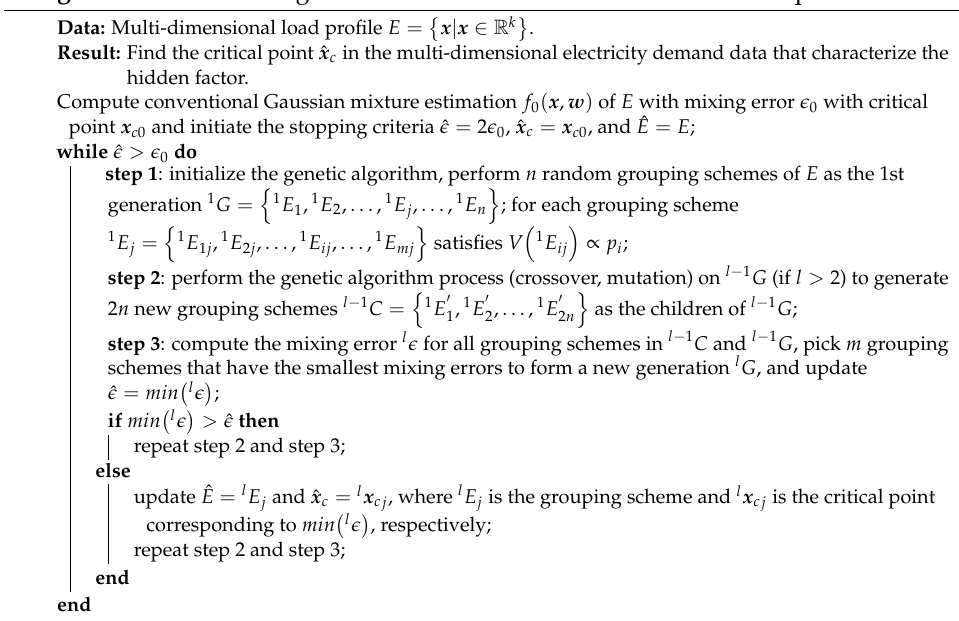
Algorithm 1: Uncovering hidden factor from multi-dimensional load